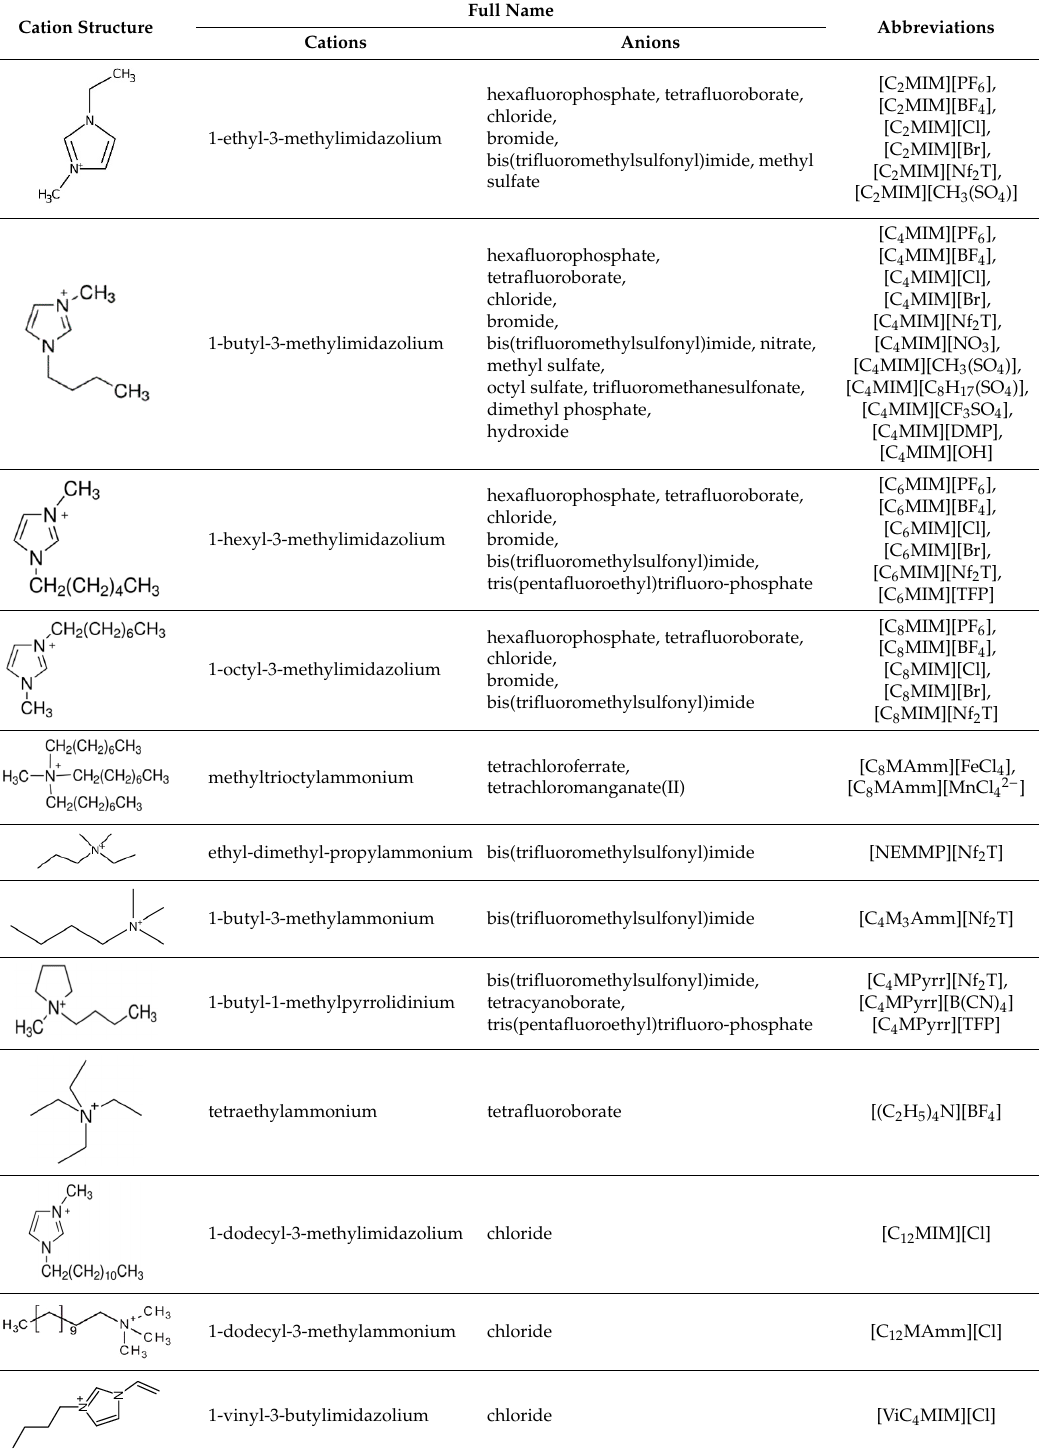
Table 1. List of ILs used in modern laboratory for drug analysis.